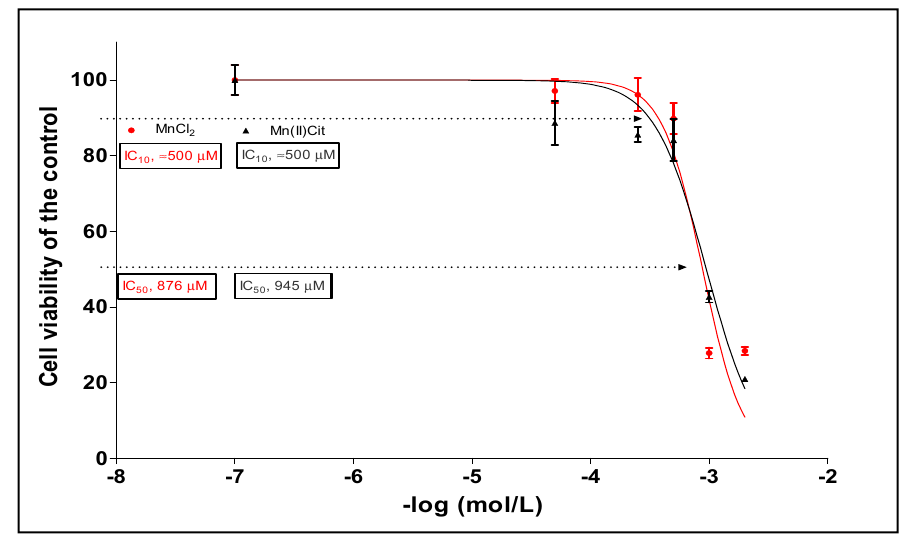
Figure 1. Cytotoxicity induced by MnCl 2 and Mn(II)Cit in RA-differentiated SH-SY5Y cells, after exposure for 24 h. Cell viability was quantified by MTT assay. The plot is representative of three biological replicates (mean ± sem); each experiment was made with five analytical replicates.